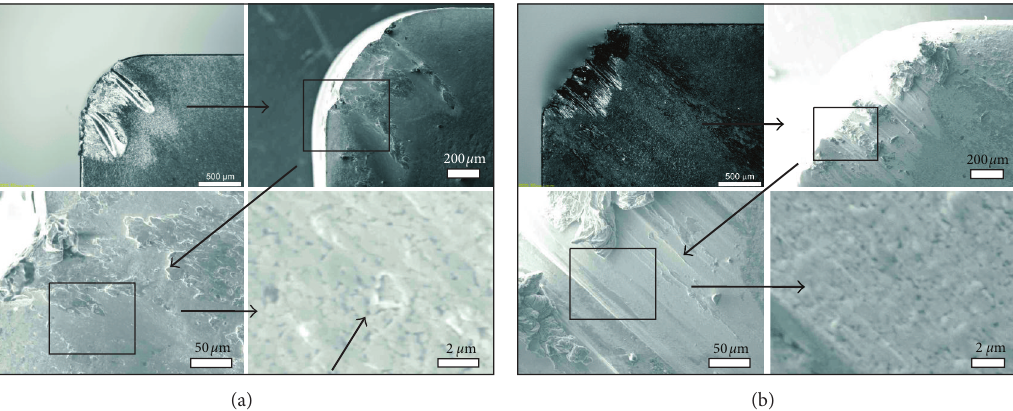
Figure 6: SEM examination of worn rake face of uncoated cutting tools. In (a) the crater wear is visible for the cutting parameters 𝑓 = 0.25 mm/rev, and 𝑎 = 0.1 mm. In the highest magnification there is a WC-grain pullout visible on the rake face. On the 𝑣 𝑐 = 100m/min, 𝑝 right (b) there is a SEM examination of worn rake face of uncoated cutting tool with 𝑣 𝑐 = 150 m/min, 𝑓 = 0.20 mm/rev, and 𝑎 𝑝 = 0.1